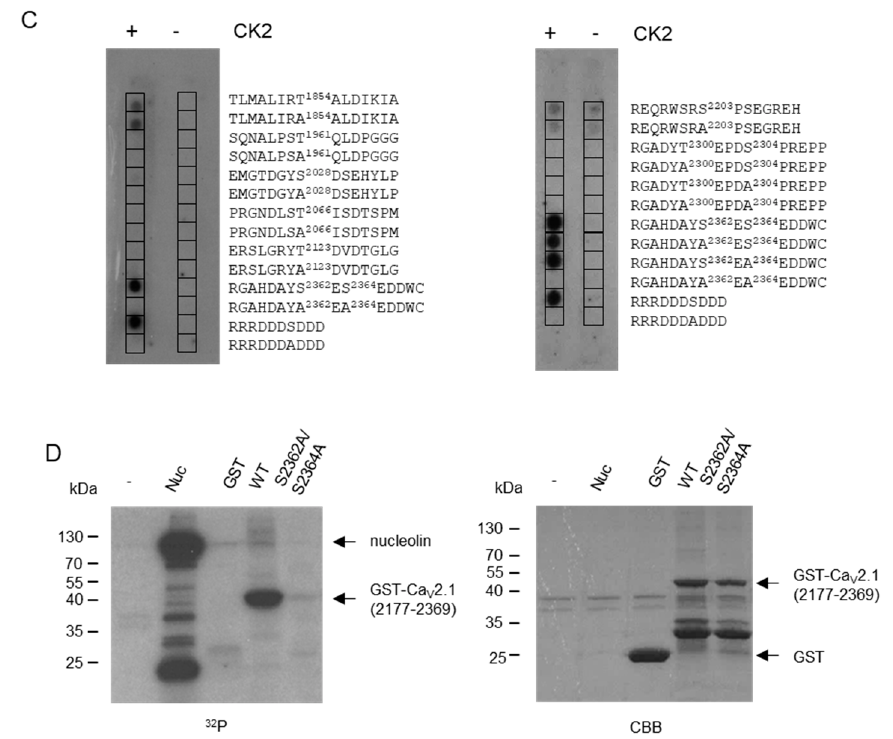
Figure 1. CK2 phosphorylates Ca V 2.1. ( A ) An in vitro phosphorylation assay was carried out by incubating lysates (80 µg) of INS-1 cells with CK2 in the presence of DMSO (control) or 10 µM CX-4945. Proteins were subjected to SDS polyacrylamide gel electrophoresis and blotted onto a PVDF membrane. A representative autoradiography ( 32 P) of the blotted proteins and the corresponding immunoblot (IB) of the same membrane with an anti-Ca V 2.1 and an anti-tubulin-specific antibody is shown. ( B ) Comparison of the amino acid sequences of the Ca V 2.1 C-terminus from different species (GenBank protein IDs: zebra fish NP_001315637.1, mouse AAW56205.1, rat XP_017456671.1, dog XP_013977279.1, human AAB64179.1). Dashes indicate a missing amino acid and spacing has been adjusted to maximize the homology of the sequences. The highlighted amino acids indicate putative CK2 phosphorylation sites with the sequence S/TxxD/E ( C ) Peptides with the putative CK2 phosphorylation sites shown in B (based on the murine sequence) were spotted on a cellulose membrane. Filters were incubated in the absence (-) or the presence of CK2 (+) and [ 32 P] γ ATP. A representative autoradiography is shown. ( D ) An in vitro phosphorylation assay was carried out by incubating equal amounts of GST, GST–Ca V 2.1 (2177-2369) wild-type or double mutant S2362A/S2364A with CK2 and [ 32 P] γ ATP. A sample with CK2 alone (-) or with nucleolin, as an established CK2 substrate, served as controls. Samples were analyzed on a 12.5% SDS polyacrylamide gel and subjected to staining with Coomassie Brilliant Blue (CBB) followed by autoradiography ( 32 P). A representative autoradiography and the corresponding CBB staining is shown.